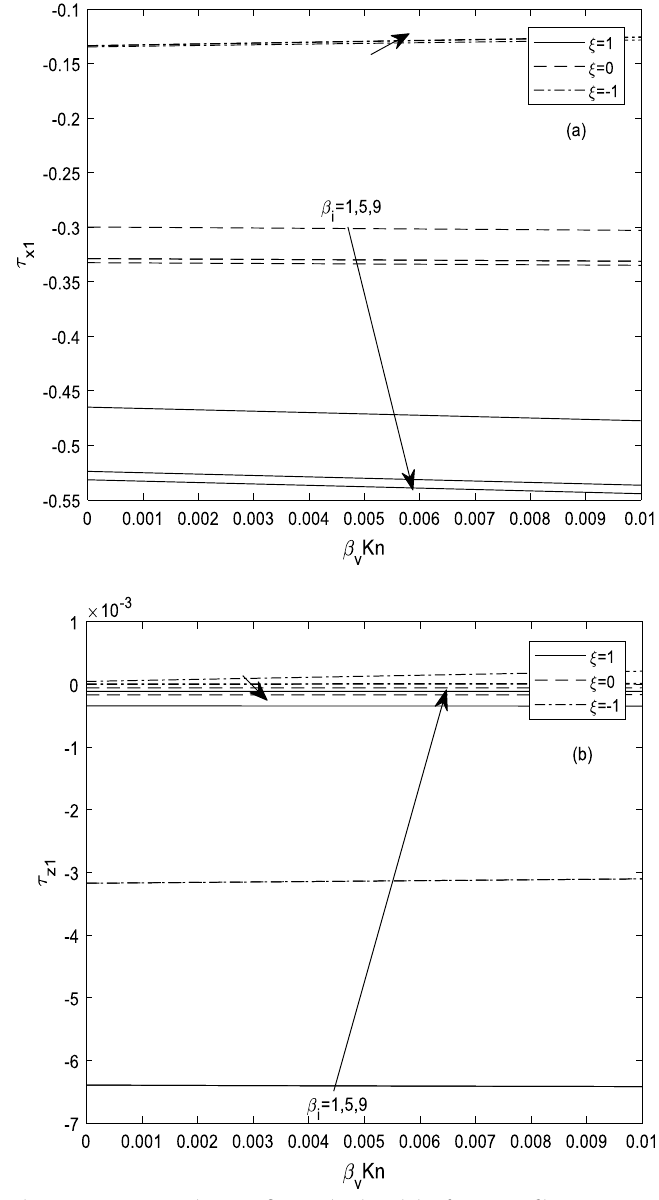
Fig. 13 a Ion-slip parameter ( β i ) on the main flow and induced skin friction profiles at y = 1 , for β v Kn = 0.05, M = 2,ln = 1.667, M = 2.0, β h = 0.10 and Pr = 0.71 . b Ion-slip parameter ( β i ) on the main flow and induced skin friction profiles at y = 1 , for β v Kn = 0.05, M = 2,ln = 1.667, M = 2.0, β h = 0.10 and Pr =